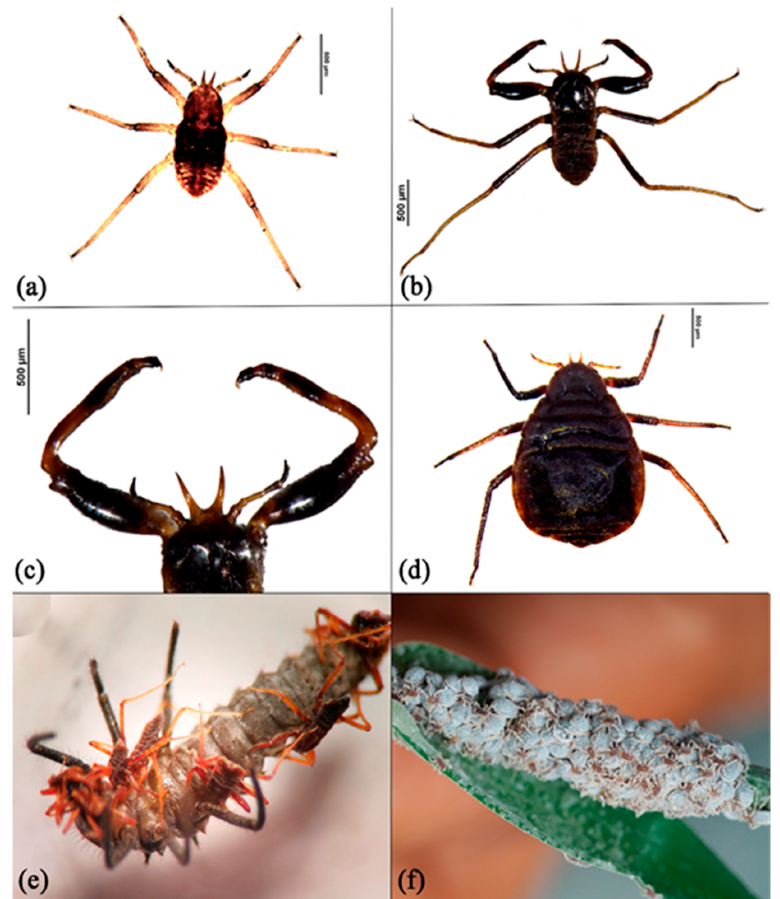
Figure 1. Dorsal view of specimens of Pseudoregma bambucicola : ( a ) first instar nymph, ( b ) soldier aphid, ( c ) front legs of soldier aphid, and ( d ) adult. ( e ) Live photo of soldiers attacking Synonycha grandis larvae. ( f ) Newly established colony on bamboo shoot.